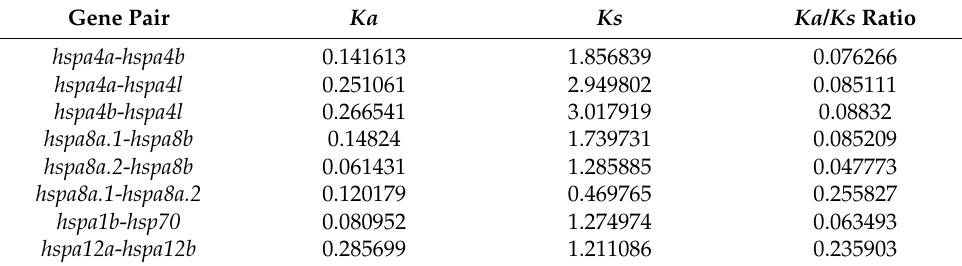
Table 2. Ka , Ks , and Ka / Ks ratios of duplicated HSP70 gene pairs.